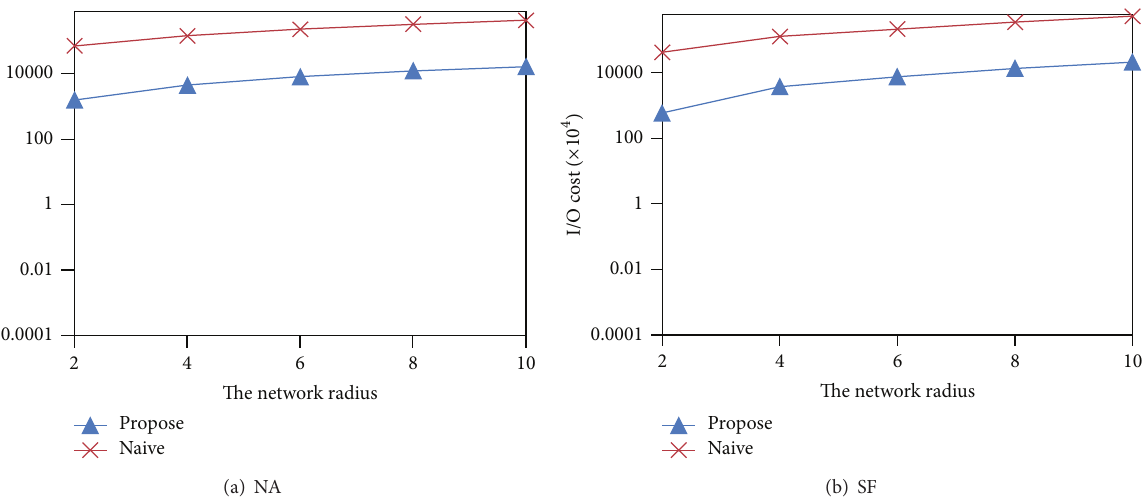
Figure 14: Effect of the network radius.